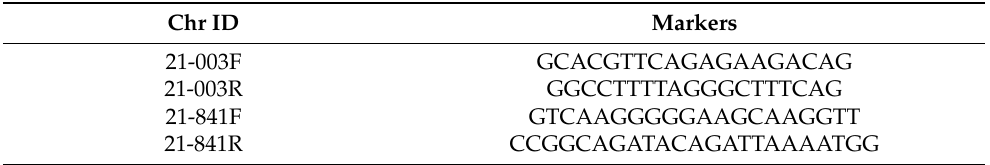
Table 3. Primer information of Spo12821 amplification.